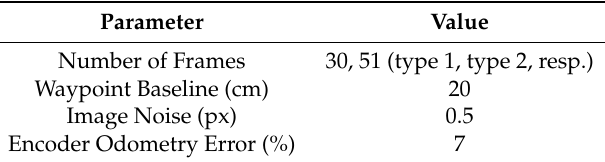
Figure 14. Artificial Floorplan 2, see [2]. Table 1. Synthetic testing